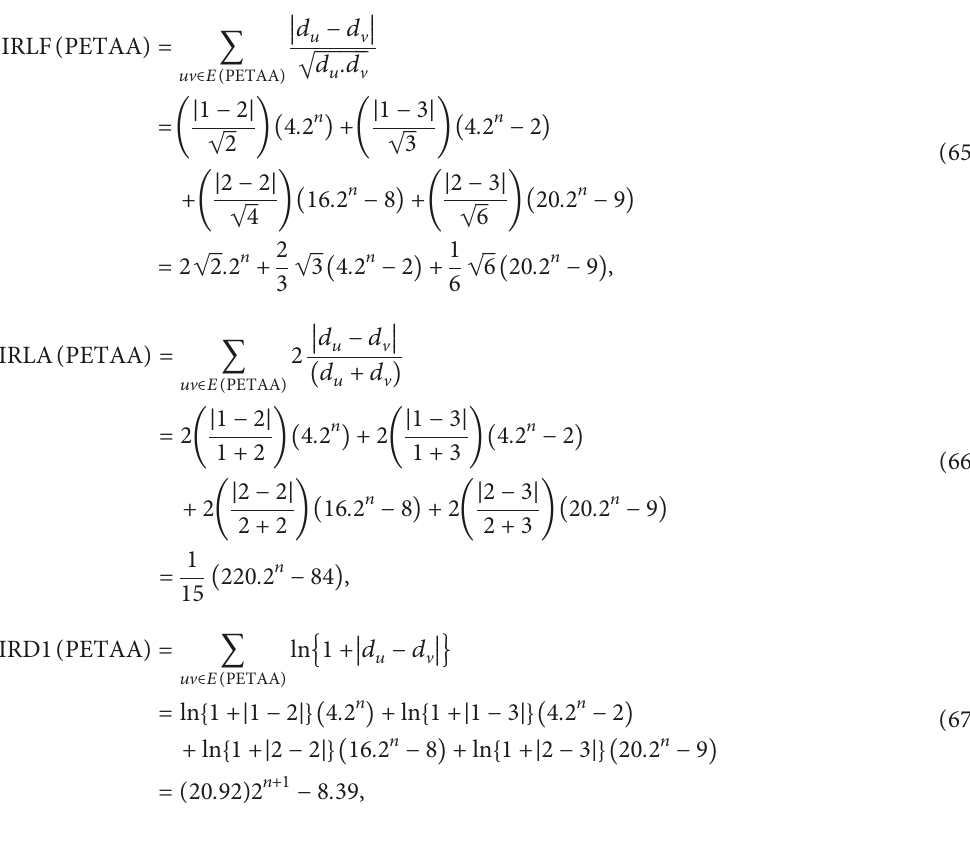
P n n , PETIM, DPZ n , and